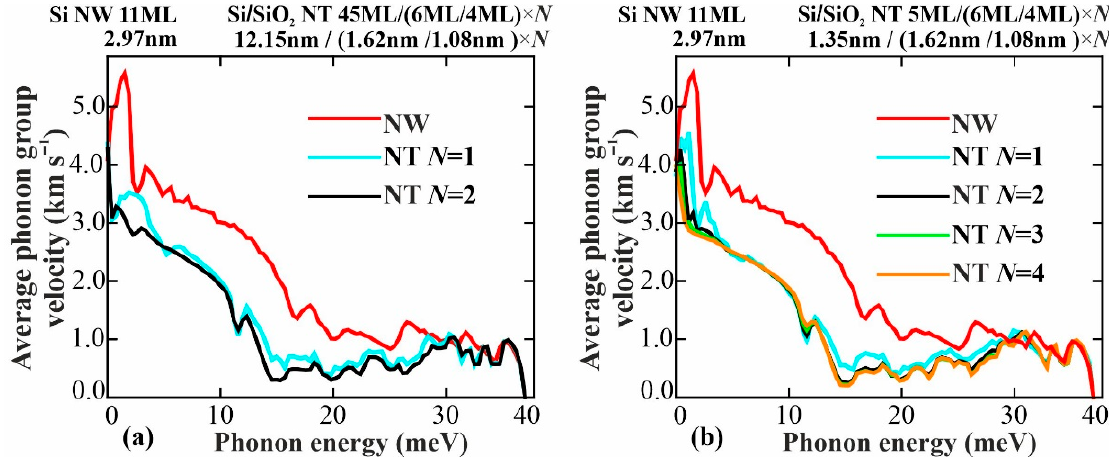
Figure 3. Average phonon group velocities as a function of phonon energies in Si/SiO 2 MNTs with the cavity cross section 45 ML × 45 ML ( a ) and 5 ML × 5 ML ( b ) and different numbers of Si/SiO 2 bilayer shells, formed by silicon layer with thickness 6 ML and silica layer with thickness 4 ML. Results for Si NW with cross section 11 ML × 11 ML are also shown for comparison.